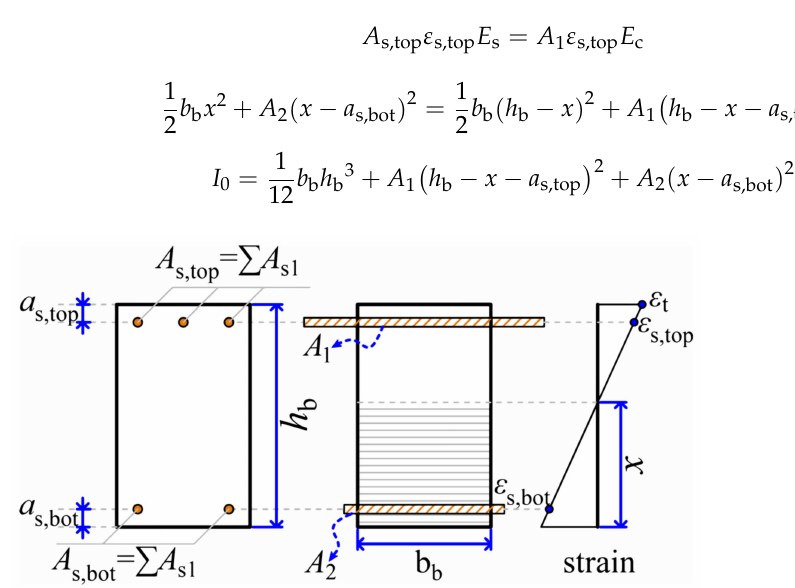
Figure 2. Equivalent section for calculating W 0 and its strain